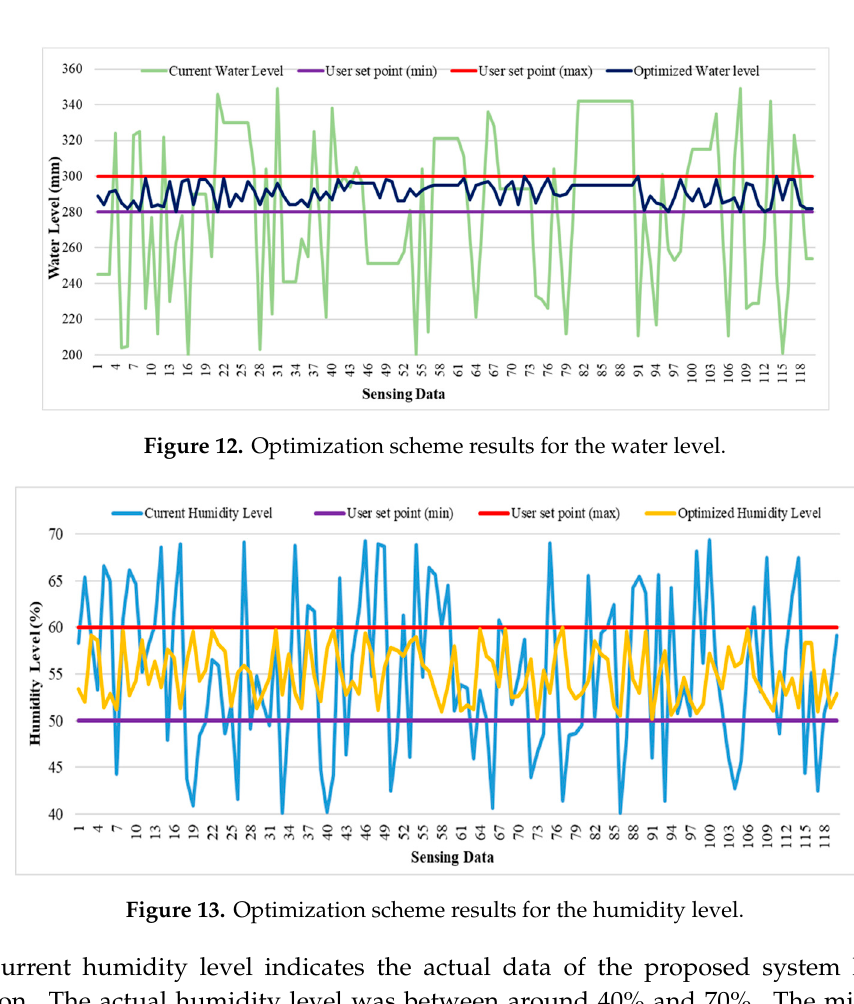
Figure 12. Optimization scheme results for the water level.